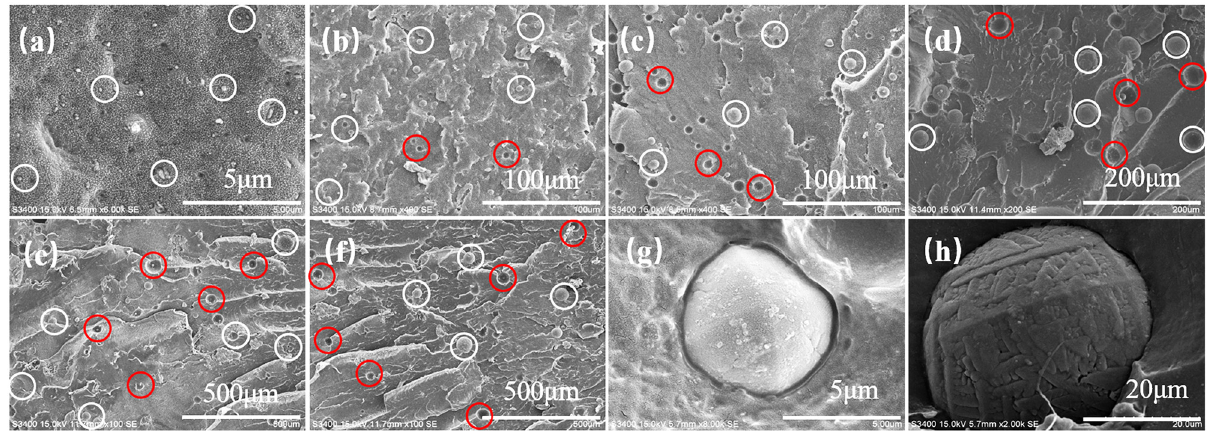
Figure 1: SEM micrographs of composite fracture surfaces with di ff erent d ¯ A : ( a ) 400 nm, ( b ) 6.5 μ m, ( c ) 10.2 μ m, ( d ) 26.7 μ m, ( e ) 37.8 μ m, ( f ) 48.6 μ m, and enlarged view of 6.5 μ m ( g ) and 48.6 μ m ( h ) .